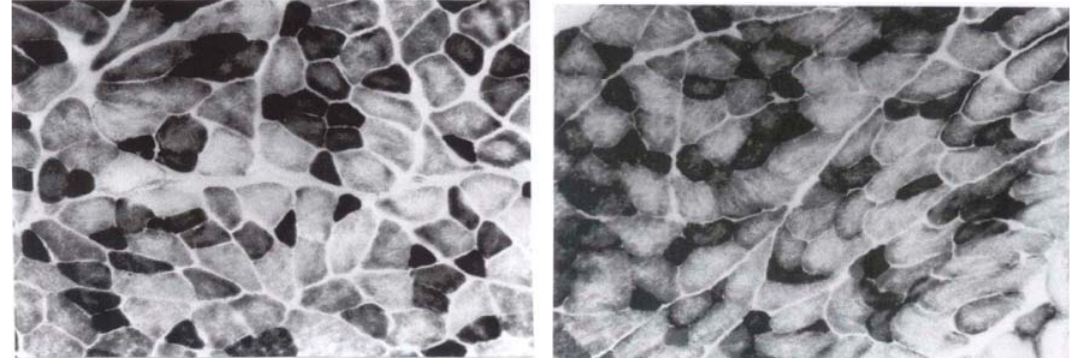
Figure 1a. SDH stain, plantaris muscle, 10-month old sedentary. Figure 1b . SDH stain, plantaris muscle, 18-month old sedentary.